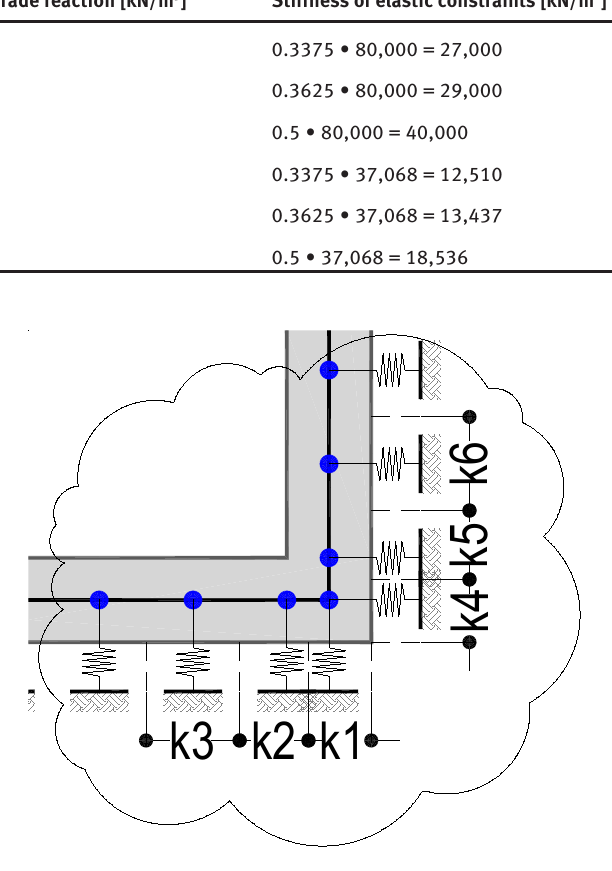
Figure 6: Elastic constrains